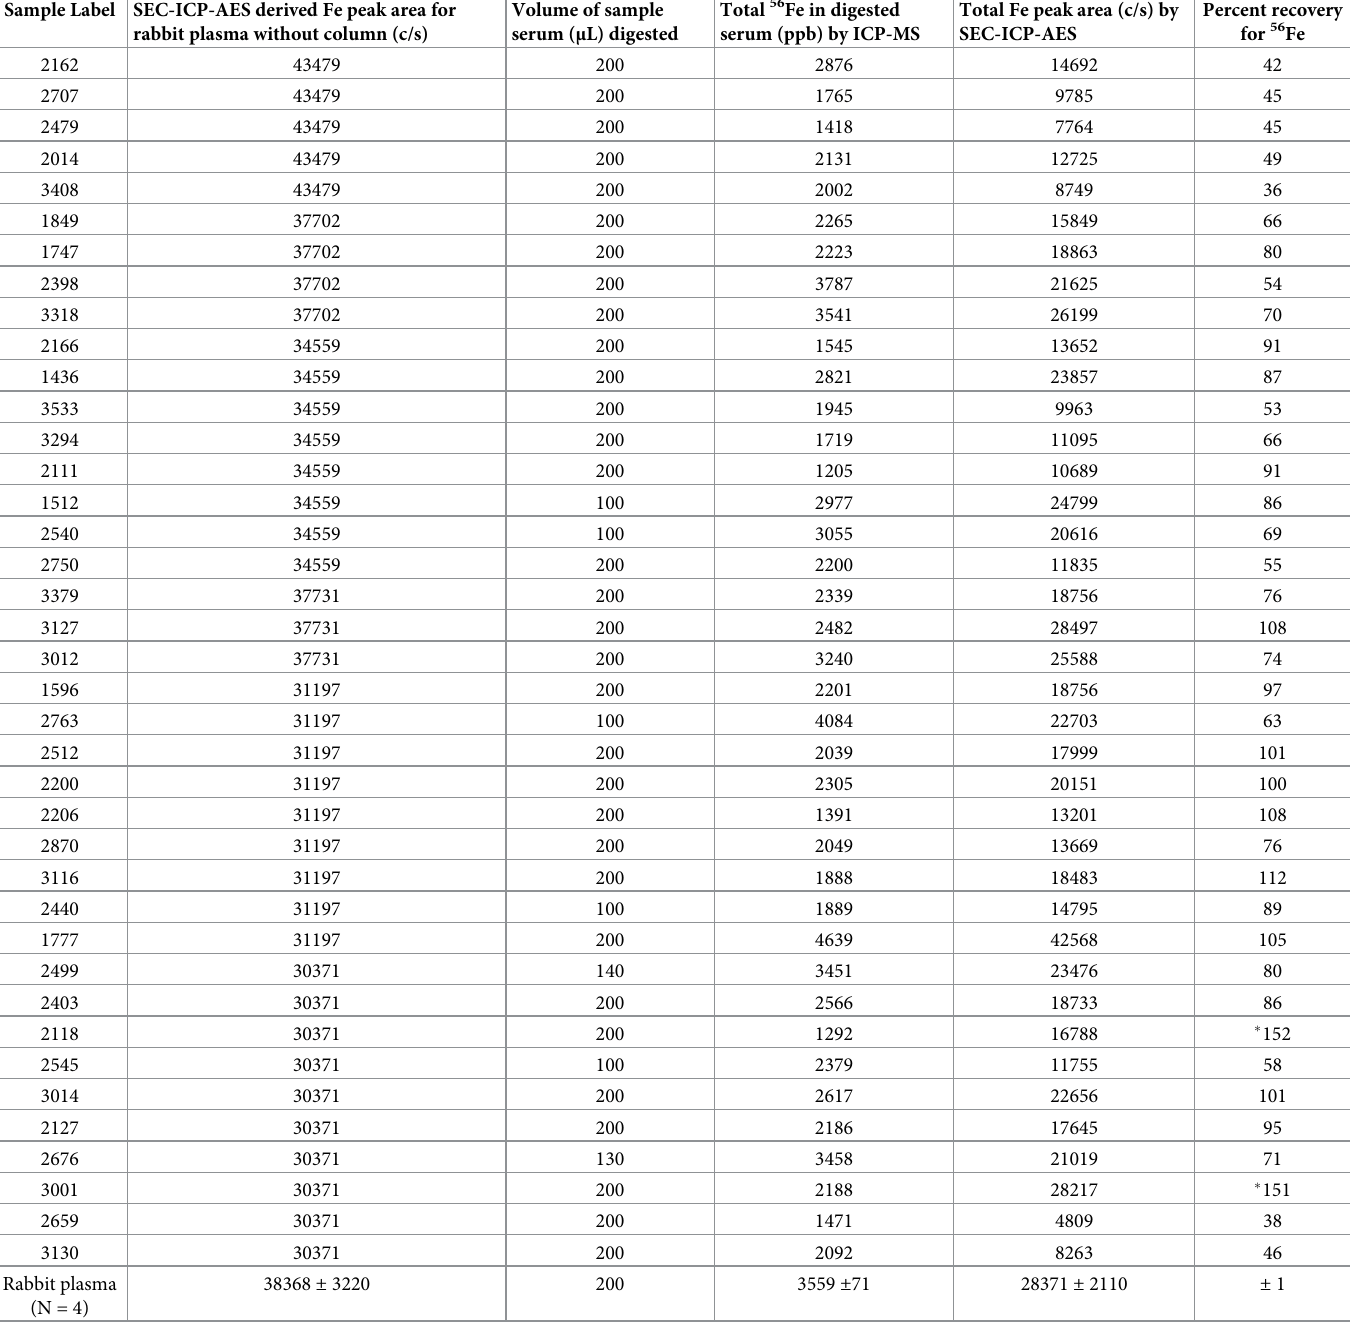
Table 1. Fe recovery of serum samples after SEC-ICP-AES analysis. Using the SEC-ICP-AES area counts for Fe that were obtained for the analysis of a rabbit plasma stock for which the total Fe concentration was known allowed us to calculate how many μ g of Fe injected corresponded to what total Fe area count. This correlation was then used to calculate the Fe recovery in % by using the total Fe of each serum sample (determined by ICP-MS) and the Fe area counts obtained after SEC-ICP-AES analysis. Sample Label SEC-ICP-AES derived Fe peak area for rabbit plasma without column